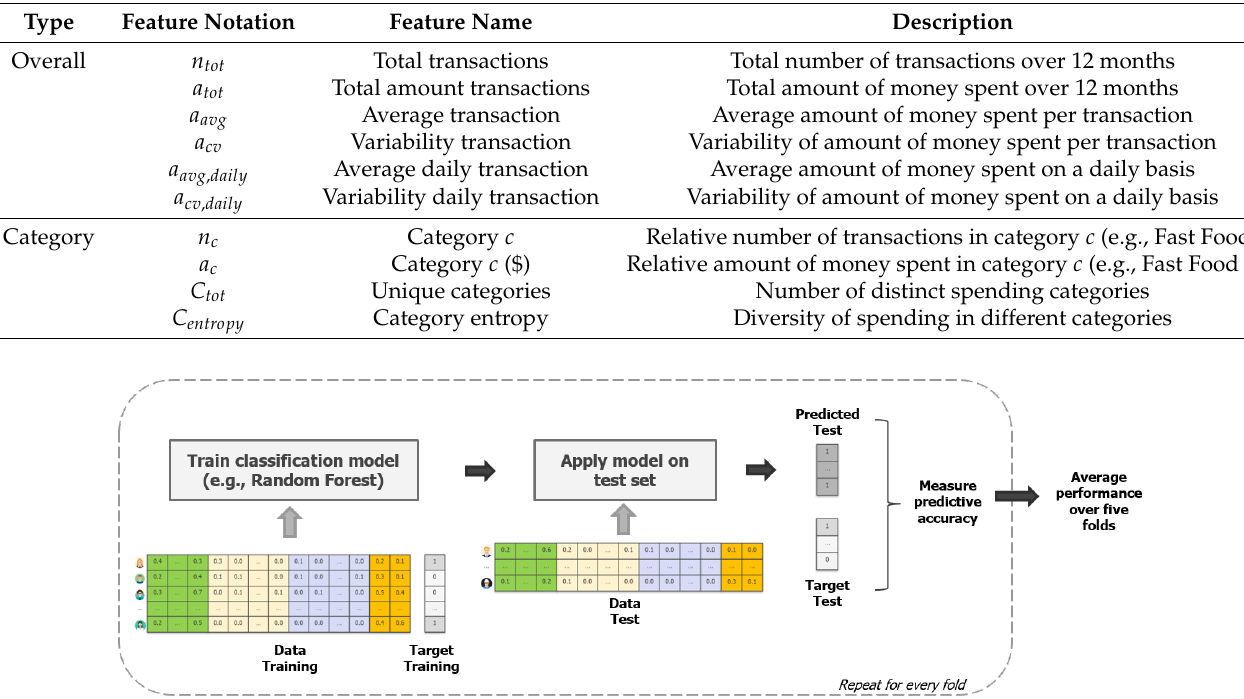
Figure A2. Five fold cross-validation procedure to develop classification models to predict BF